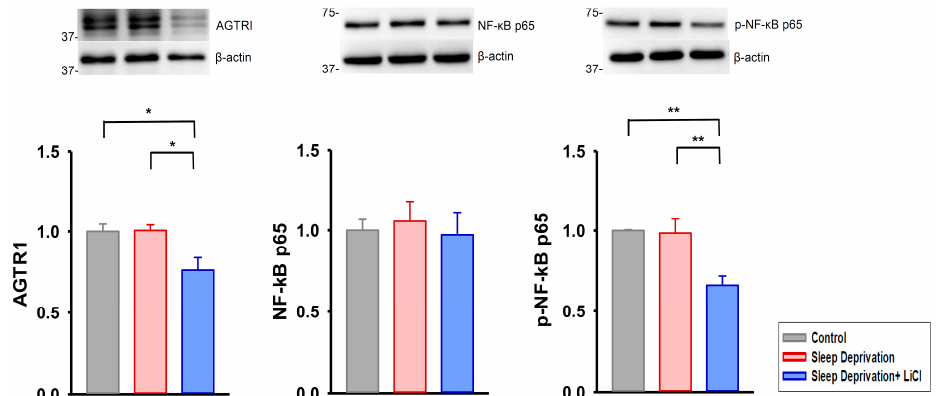
Figure 4. Angiotensin II cascade in REM sleep deprivation with and without lithium treatment. Compared with the REM sleep-deprived hearts ( n = 5), the lithium-treated REM sleep-deprived hearts ( n = 5) had lower expression levels of angiotensin II receptor type 1 (AGTR1) and phosphorylated nuclear factor kappa B (NF- κ B) p65. * p < 0.05; ** p < 0.01.